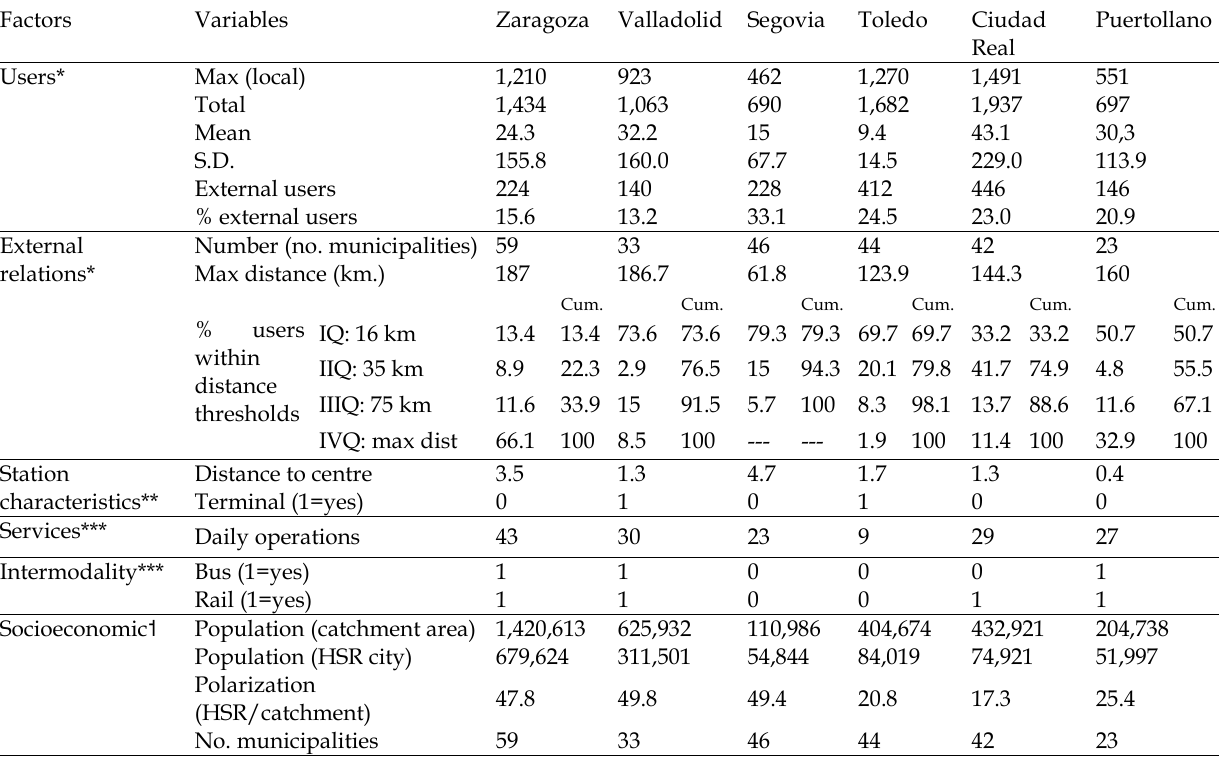
Table 1. HSR station characteristics and ridership